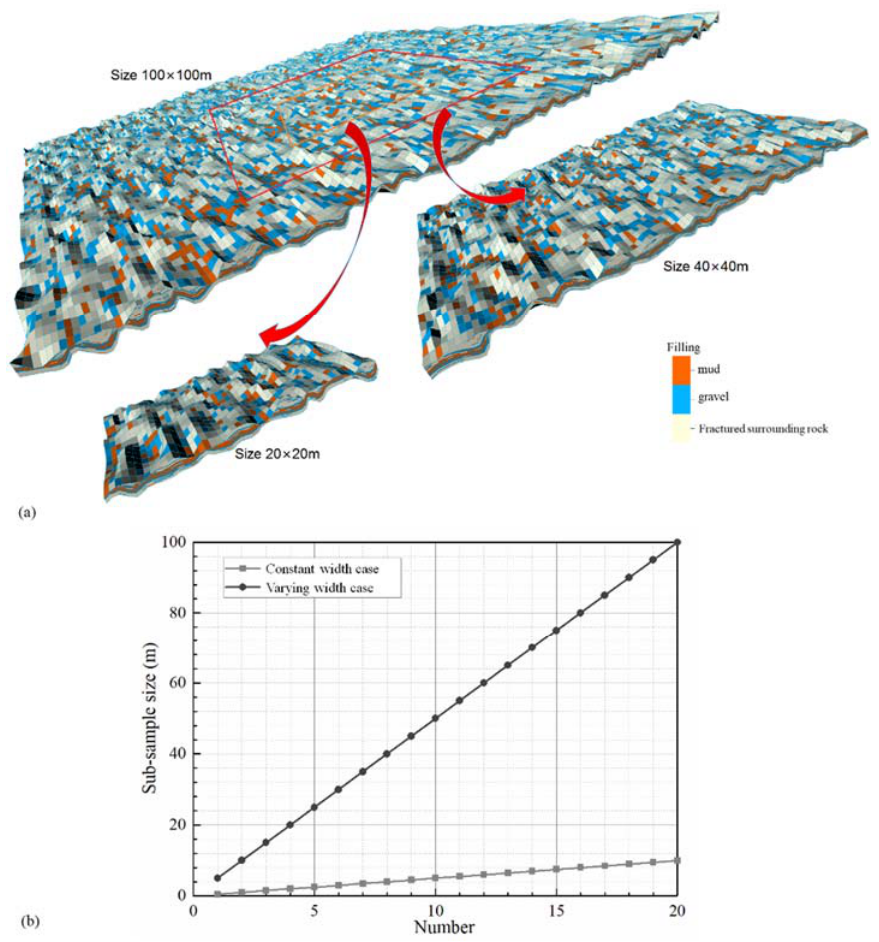
Figure 6. Sketch illustrating the sub-samples with different scales regularly extracted from a realization.